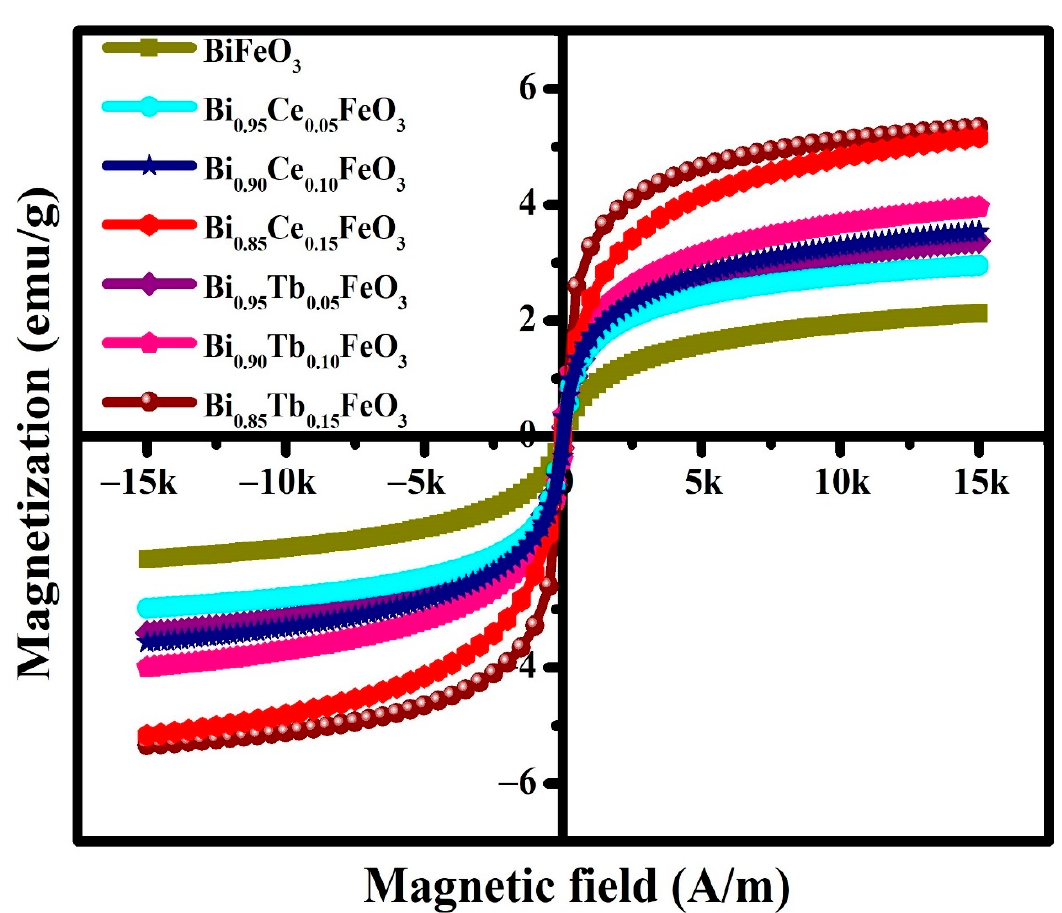
Figure 5. Magnetization ( M ) versus field ( H ) hysteresis loops for the prepared BFO: RE, measured at 300 K.